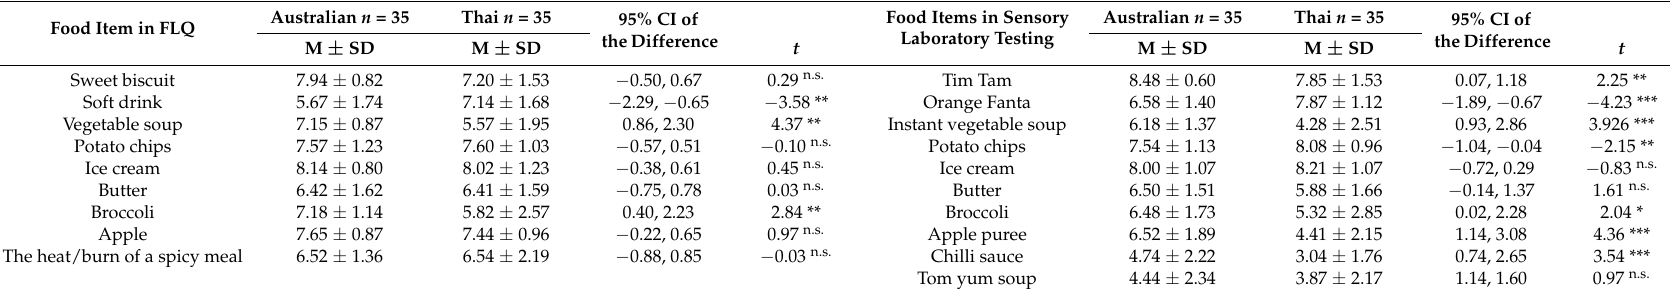
Table 5. Comparison between the food liking questionnaire and laboratory-based liking assessment rating between Australian and Thai samples Australian n = 35 Thai n = 35 Food Item in FLQ Sweet